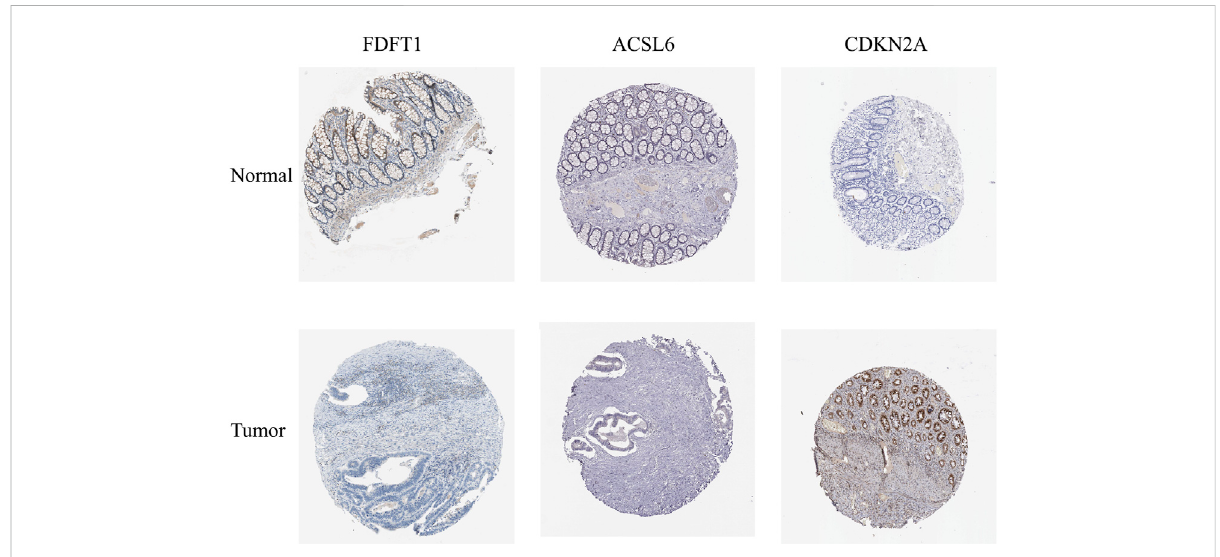
FIGURE 11 Veri fi cation of the expressions of ferroptosis-associated genes in CRC and normal colorectal tissues using HPA